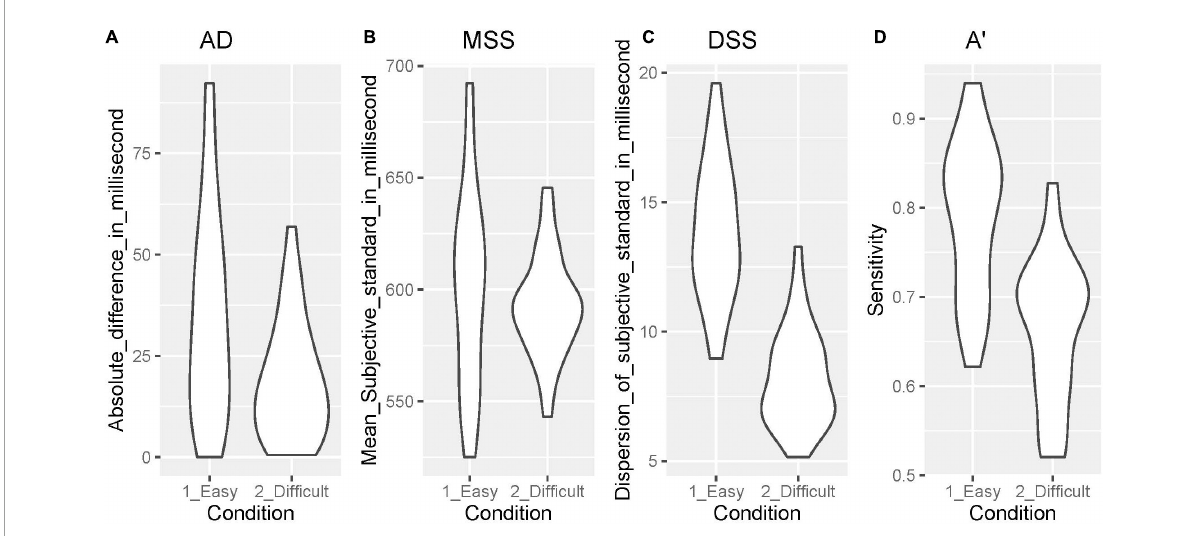
FIGURE3 Data distribution of AD, MSS, DSS, and A’ . (A) AD, (B) MSS, (C) DSS, (D) A’ . AD, absolute difference between the real standard and mean of the subjective standard; MSS, mean of the subjective standard; DSS, dispersion of the subjective standard; A, sensitivity independent of the response criterion according to the signal detection